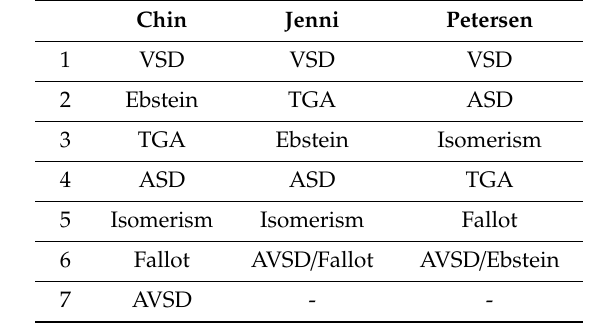
Table 5. Rank of LVNC prevalence among congenital heart diseases according to Chin, Jenni, and Petersen (apex). Chin Jenni Petersen 1 VSD VSD VSD 2 Ebstein TGA ASD 3 TGA Ebstein Isomerism 4 ASD ASD TGA 5 Isomerism Isomerism Fallot